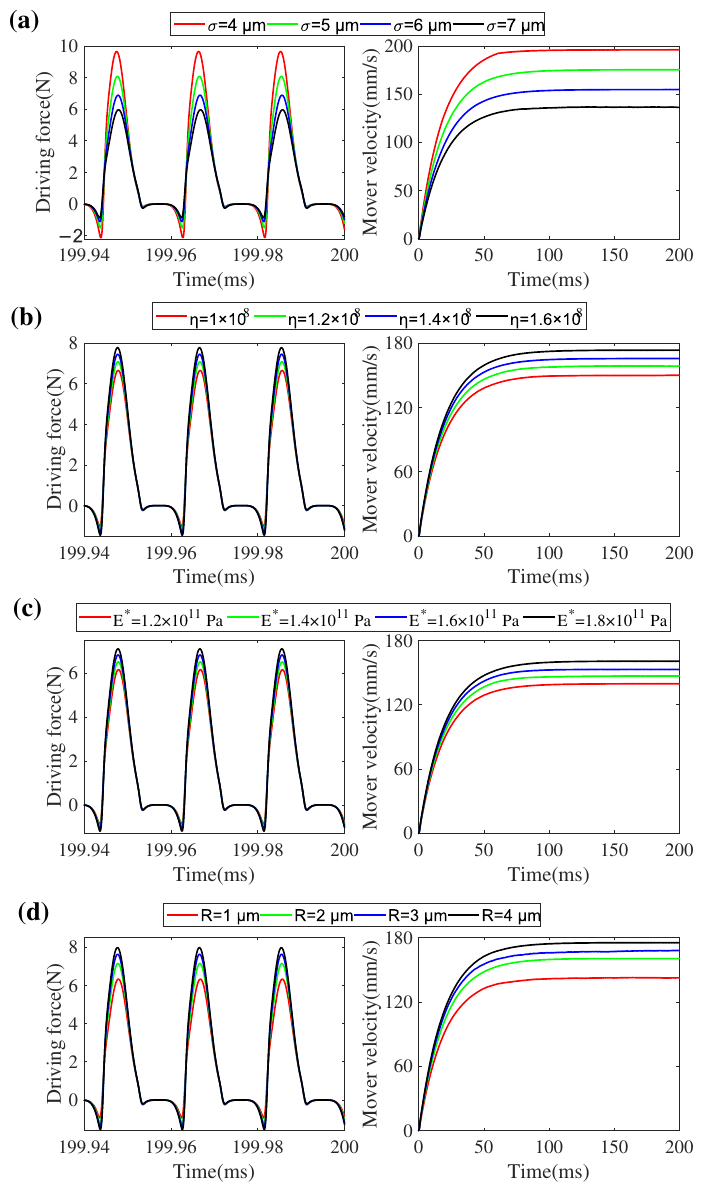
Figure 34. Effects of the micro-topography parameters on the driving force and the mover velocity response: ( a ) effect of roughness ( σ ), ( b ) effect of areal density of asperity ( η ), ( c ) effect of elastic constant ( E ∗ ), and ( d ) effect of the curvature radius of asperity ( R